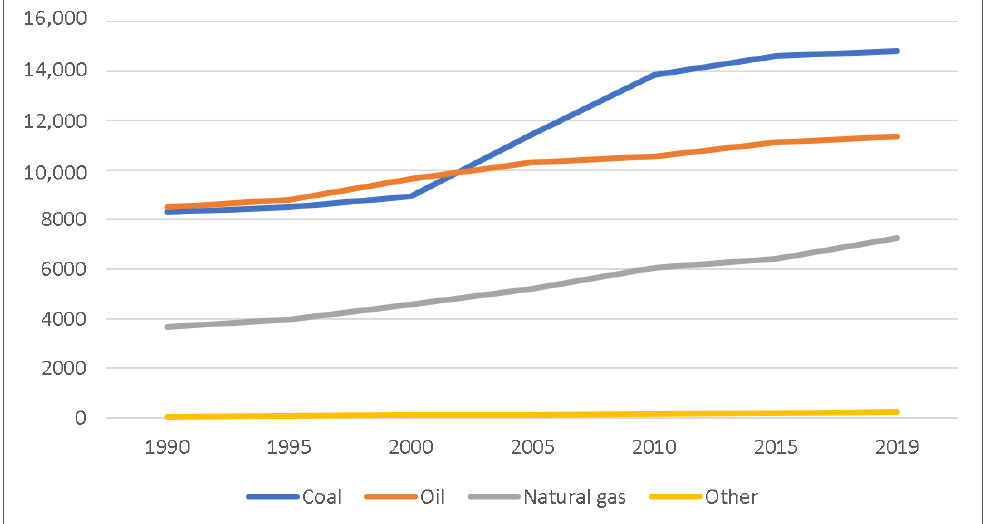
Figure 8. Global CO 2 emissions in electric energy production by source and year (1990 – 2019), de- rived from [19].